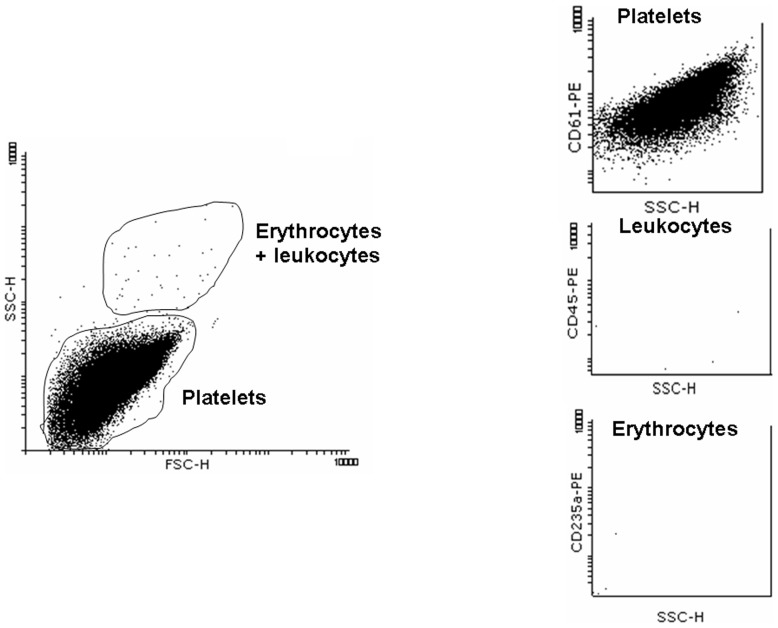
Flow cytometry analysis of platelets, leukocytes and erythrocytes in the PRP.On the left, representative flow cytometry graph to detect platelet population according to size-scatter and forward-scatter. On the right, representative flow cytometry graphs to detect positivity to CD61, CD45 and CD235a in the PRP that stain platelets, leukocytes and erythrocytes respectively.